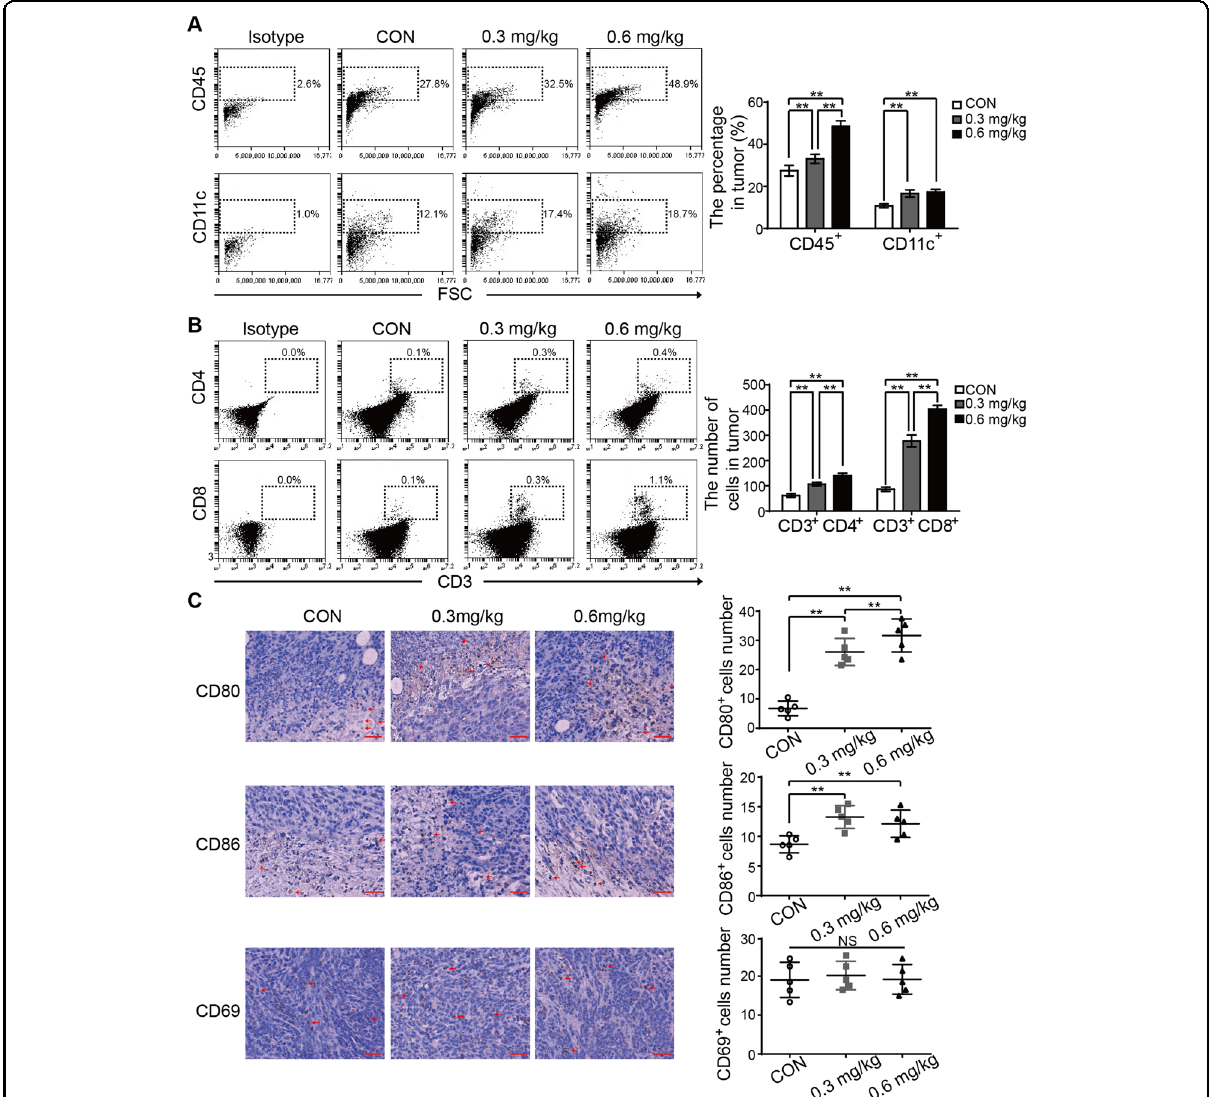
Fig. 5 Oleandrin activates anti-tumor immune response in mice. Tumor primary cells were collected from the tumor-bearing mice and detected by fl ow cytometry. A TIL and tumor in fi ltrating DCs were analyzed by staining with CD45 and CD11c. The results were represented as percentage in tumors. B Tumor in fi ltrating T cells were analyzed by staining with CD3, CD4, and CD8. The absolute numbers of CD4 + and CD8 + T cells in tumors were expressed as mean ± SD. C Mouse tumor samples were stained using IHC for CD80, CD86, and CD69 expressions. Cell numbers were counted under a 40× objective. Each dot denotes the immune cell number from a tumor section. Mean and standard deviation of immune cell number in each group are shown. Scale bar = 40 μ m. n = 5, ** p < 0.01 vs. control. CON,